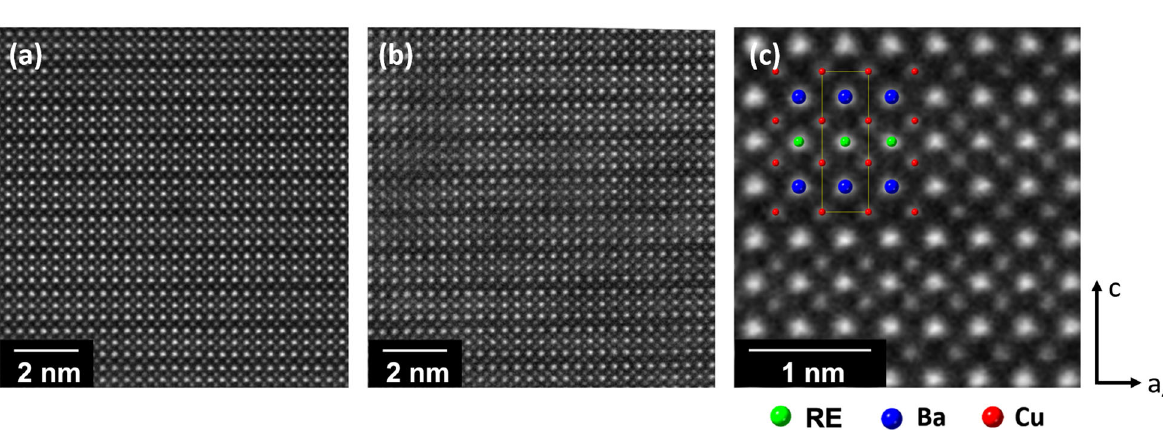
Fig. 2 Typical examples of aligned stacks of 10 HAADF images. a HAADF image of the pristine sample. b HAADF image of the 10 16 cm − 2 He + -irradiated sample. c Magni fi ed image from a region of a with a schematic showing the cation positions in the unit